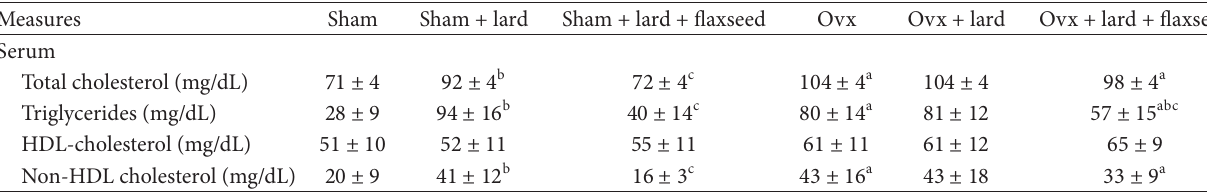
Table 3: Mean ± SD values for lipid profile in studied groups.